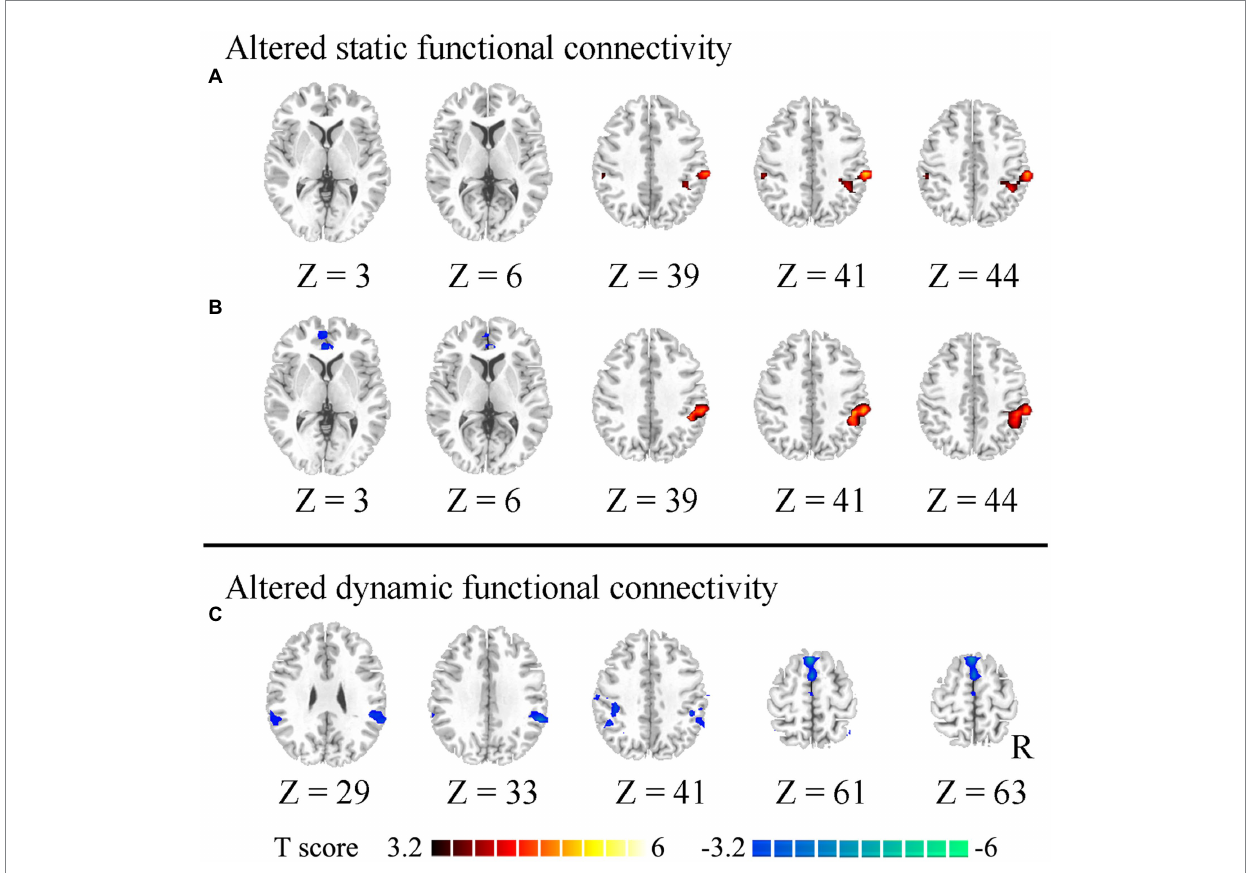
FIGURE 1 Altered static and dynamic functional connectivity (FC) of insular subregions. (A) indicates increased static FC between the right ventral insula and right temporoparietal junction (TPJ) in the high worry-proneness group compared to the low worry-proneness group. (B) indicates increased static FC between the left ventral insula and right TPJ and decreased static FC between the left ventral insula and pregenual anterior cingulate cortex in the high worry-proneness group. (C) indicates decreased dynamic FC between the right posterior insula and TPJ, as well as supplementary motor area in the high worry-proneness